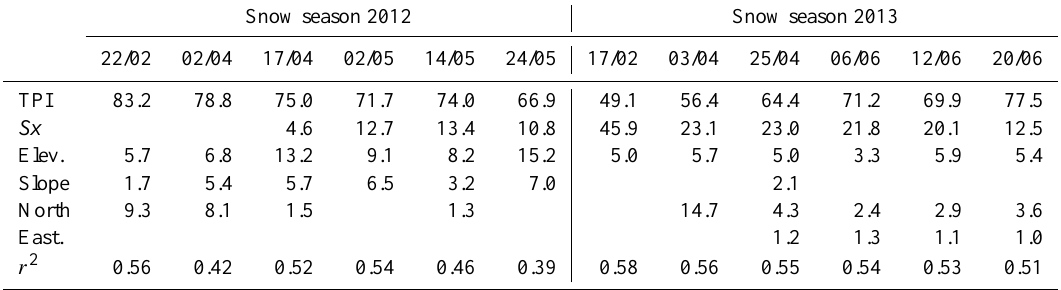
Table 5. Contribution of the various topographic variables to the explained variance of SD distribution in the binary regression tree models for 2012 and 2013. Values have been rescaled from 0 to